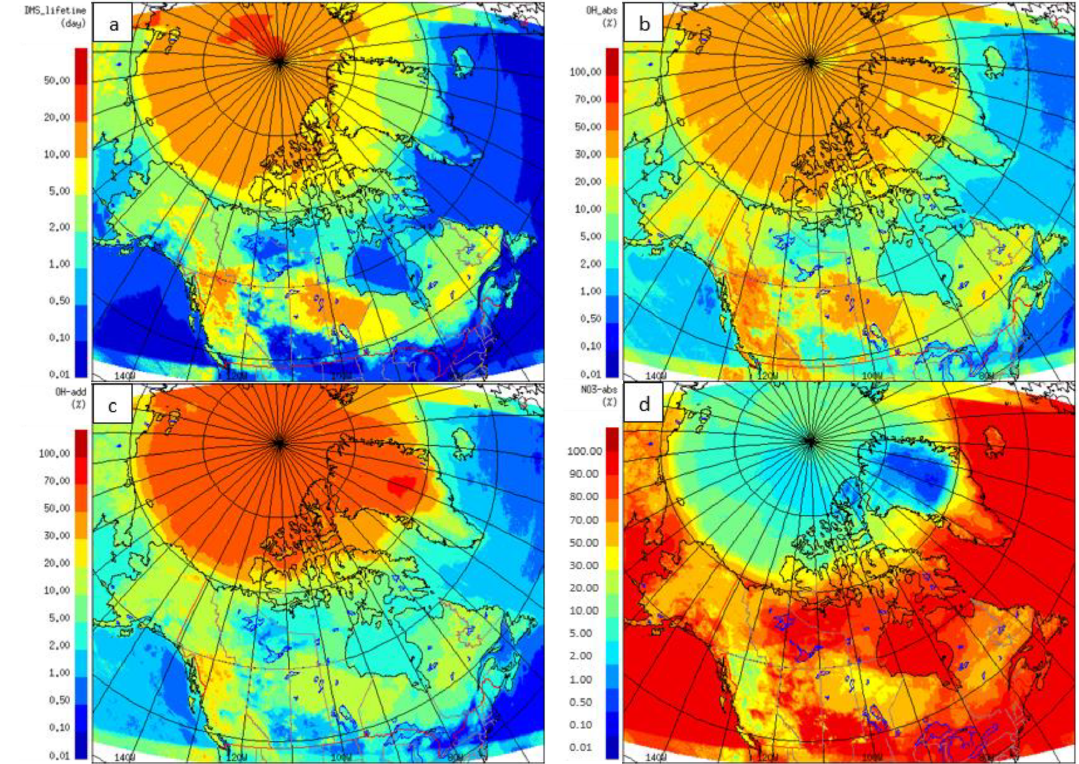
Figure 11. (a) DMS(g) average lifetime for July 2014, and the percentage (%) contribution of the each pathway: (b) abstraction with OH, (c) addition with OH and (d) abstraction with NO 3